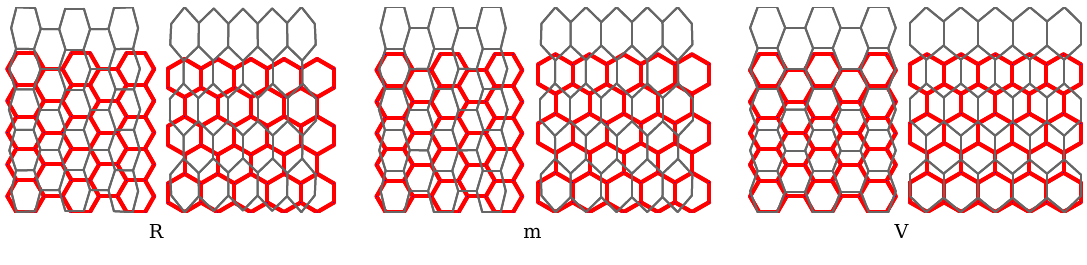
Figure 3. The initial and deformed shapes (scale factor 10) of the nearly square lattice of ≈ L size 5 ( L ) is shown for the three types of BC. The two chiralities armchair (left) 1 , 2 3 , 4 and zigzag (right) are presented for every BC